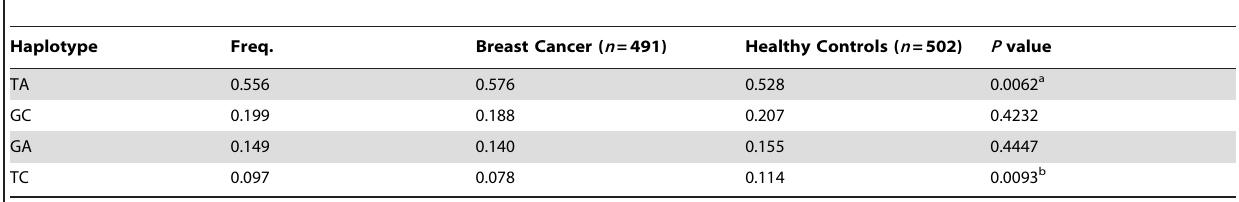
Table 2. Haplotype frequencies in breast cancer patients and healthy controls.